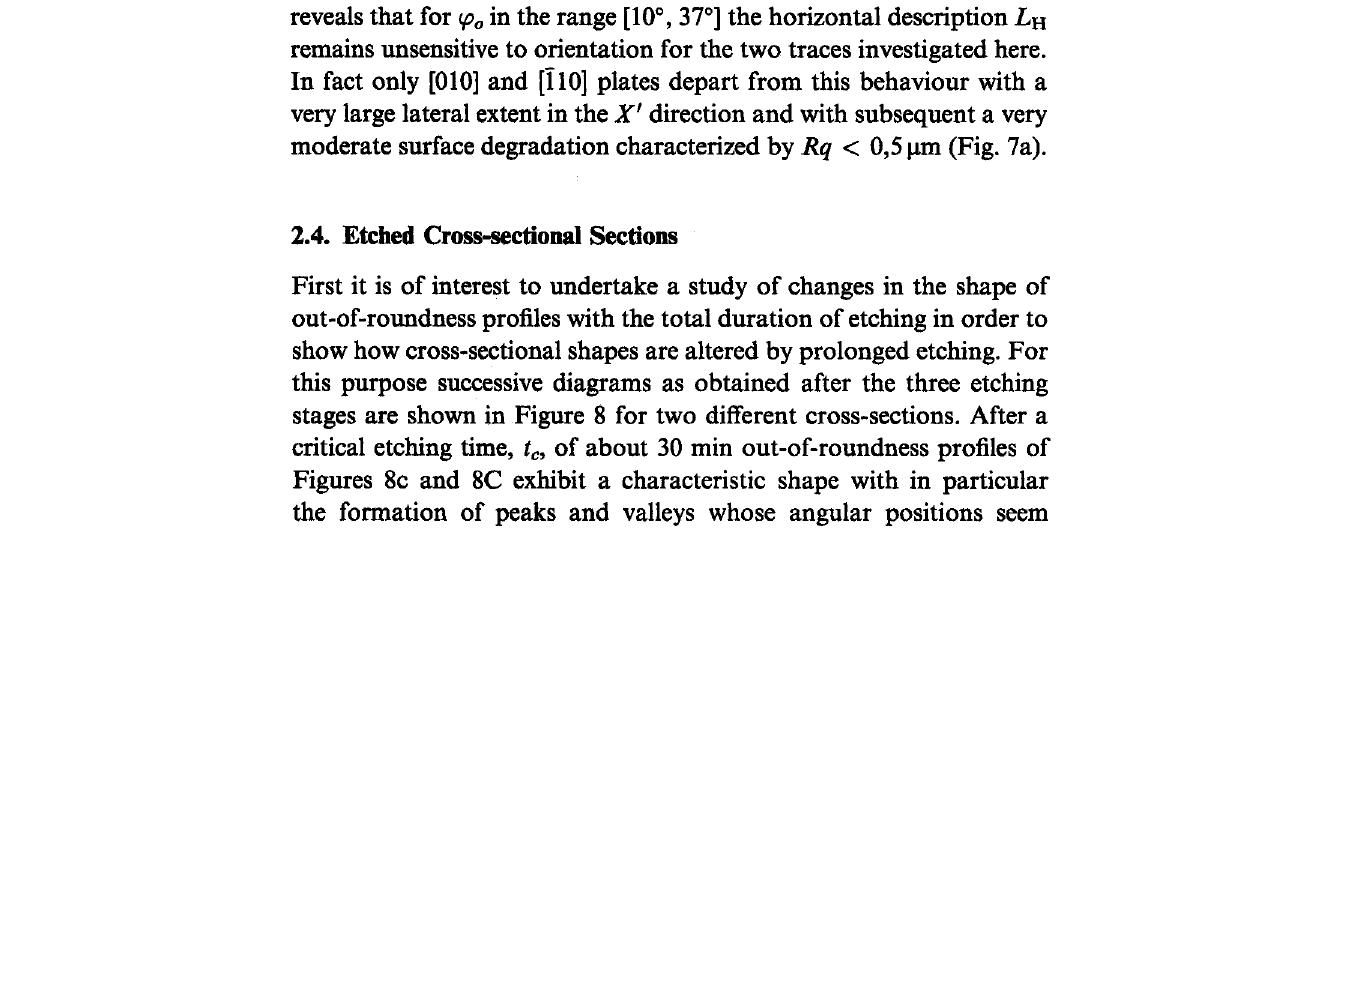
. FIGURE 7 (a) Evolution of the root-mean-square roughness parameter Rq with o along X’ axis and along (100) axis Variation ofthe horizontal descriptor LH with o along respectively X’ (b) and (010) axis